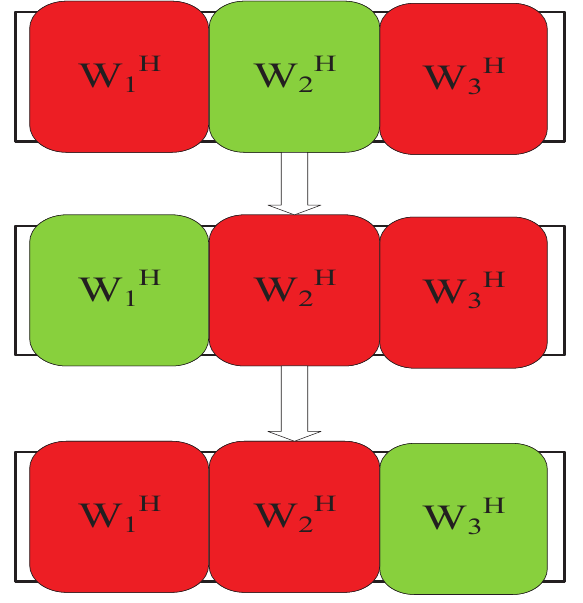
Figure 9. ISS-2 update